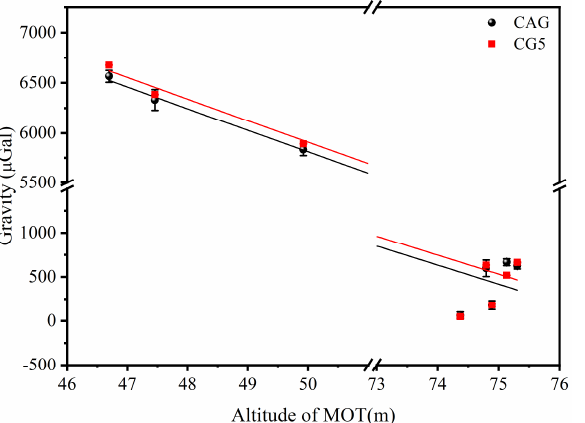
Figure 8. The relationship between the elevation and the gravity of measured point which obtained by CAG (the black dots) and CG-5 (the red dots) respectively.